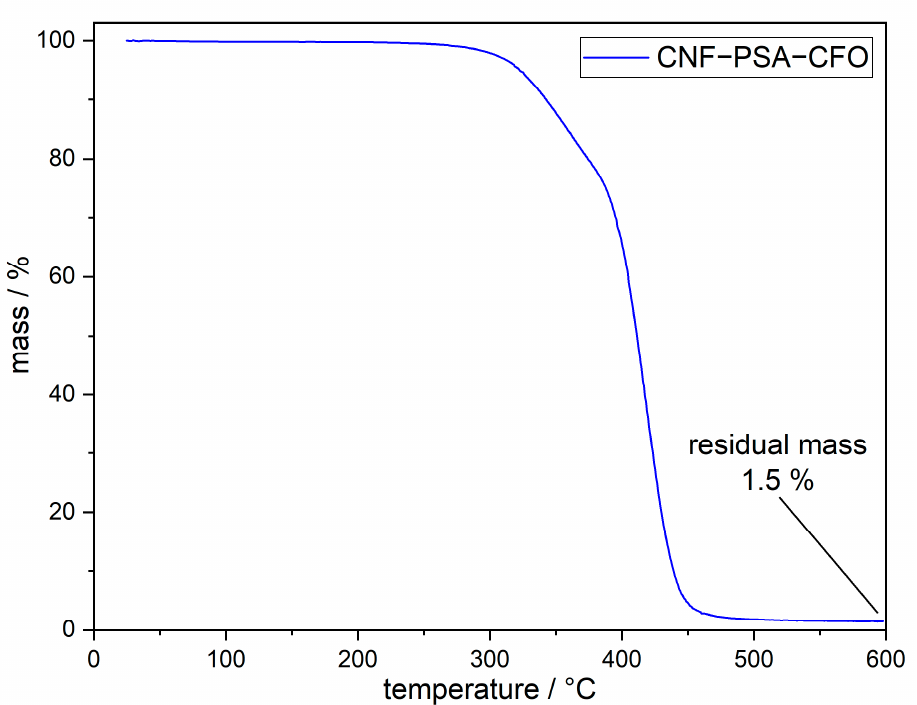
Figure 6. TGA curve of CNF–PSA–CFO under inert nitrogen atmosphere.